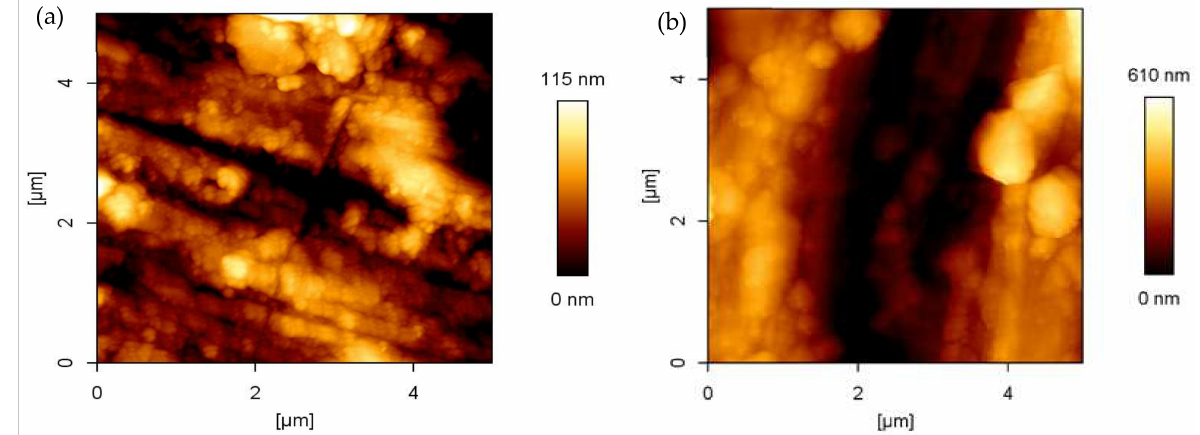
Figure 9. Oxide surface roughness of AA1050 ( a ) at RT and ( b ) annealed at 400 ◦ C.